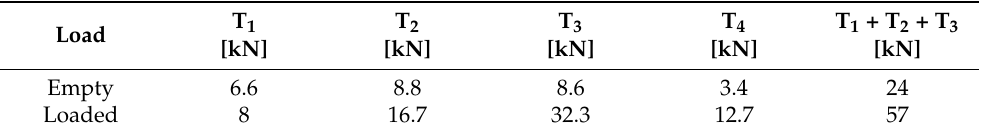
Table 2. Tangential forces between the road vehicle and the railway wagon platform during emer- gency braking of the train ( a = 1.5 m/s 2